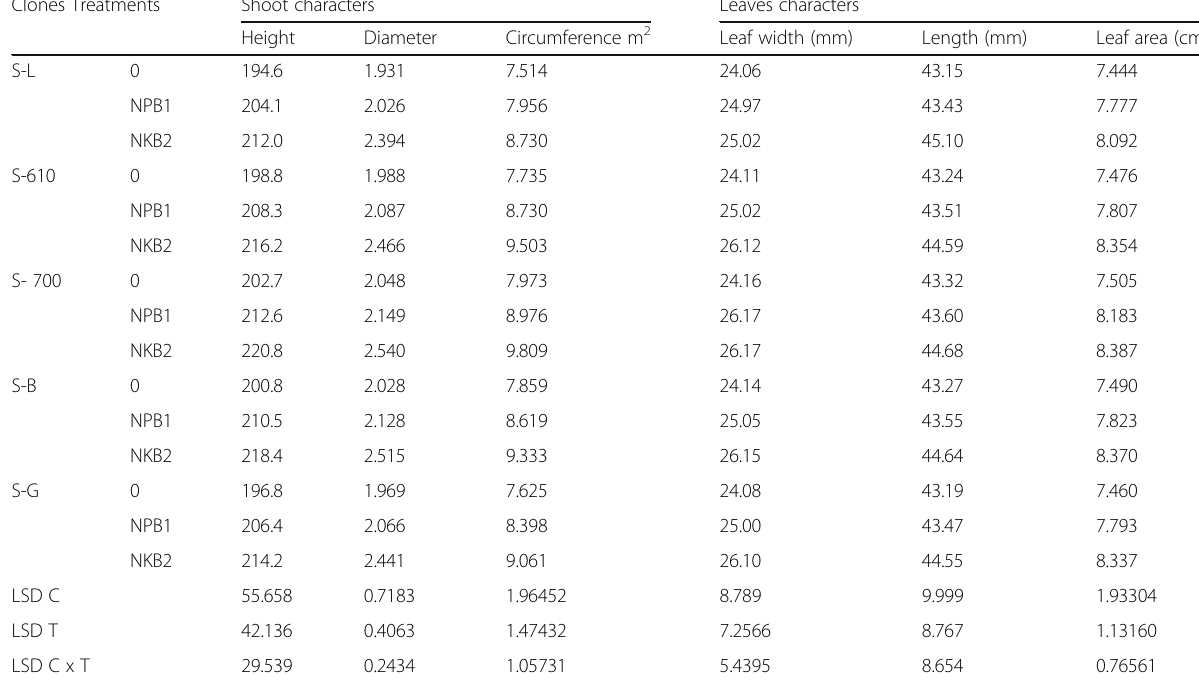
Table 3 Effect of rates of NPB on growth characters of clones jojoba plants at 13 years Clones Treatments